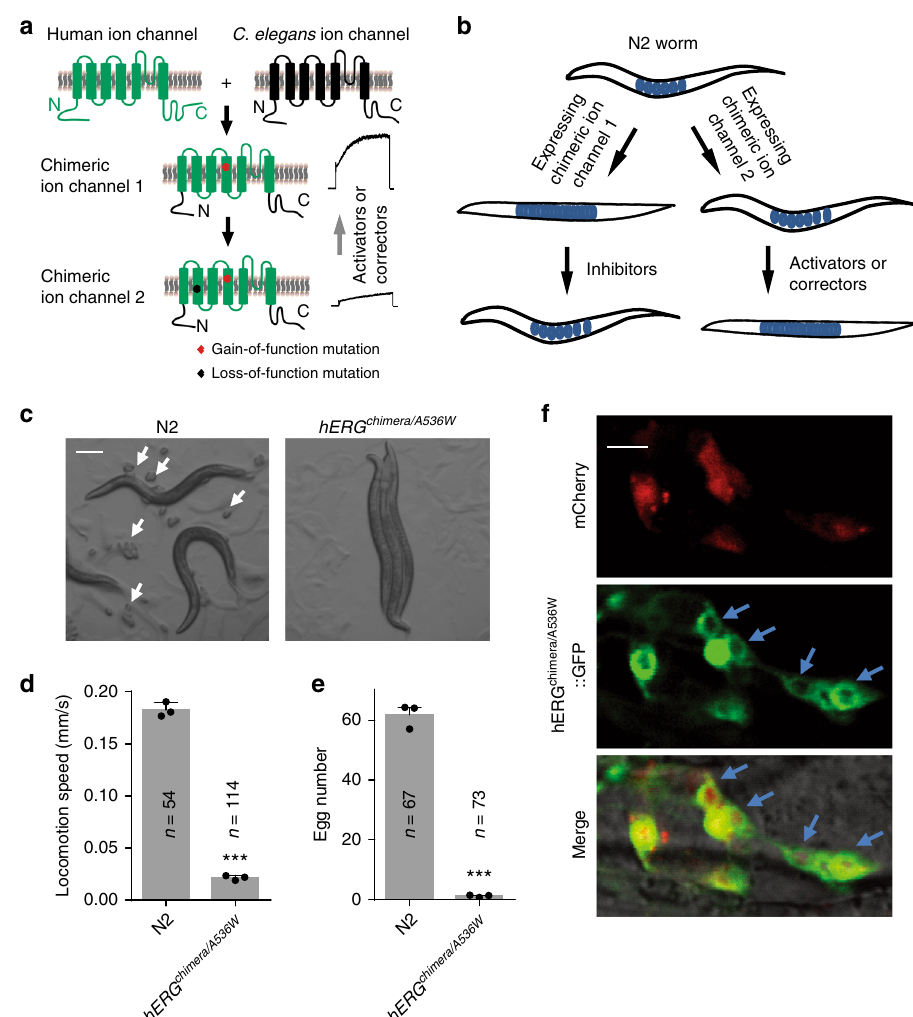
Fig. 1 C. elegans models of channelopathies show behavioral defects. a Schematic illumination of chimeric ion channels. The chimeric ion channels consist of transmembrane domains and their connecting loops of a human ion channel, and N-/C-terminus of its C. elegans homolog. The gain-of-function mutation was expected to alter cell excitability and consequently induce behavioral defects in transgenic worms. b Schematic illumination of generating animal models of channelopathies and strategy for drug screenings. Transgenic worms expressing chimeric ion channel 1 proteins will exhibit clear behavior defects. Drugs that alleviate the phenotypic defects could be inhibitors of the channel. Transgenic worms expressing chimeric ion channel 2 proteins will show no or weak behavior defects due to the reduced channel function, and drugs aggravate the worms ’ behavioral defects are potential activators or functional correctors of the channel. c Microscopy images of wild-type N2 and hERG Chimera/A536W transgenic worms. Scale bar, 200 µ M. White arrows indicate C. elegans eggs. d , e Locomotive ( d ) and egg-laying ( e ) behaviors of of young adult wild-type N2 and hERG Chimera/A536W transgenic worms. f Fluorescent images of worms expressing both mCherry and hERG chimera/A536W ::GFP proteins that were driven by the unc-103 promoter. Blue arrows indicate head neurons. Scale bar, 10 μ m. All data shown are mean ± s.e.m. *** P < 0.001 (Student ’ s t -tests for d , e